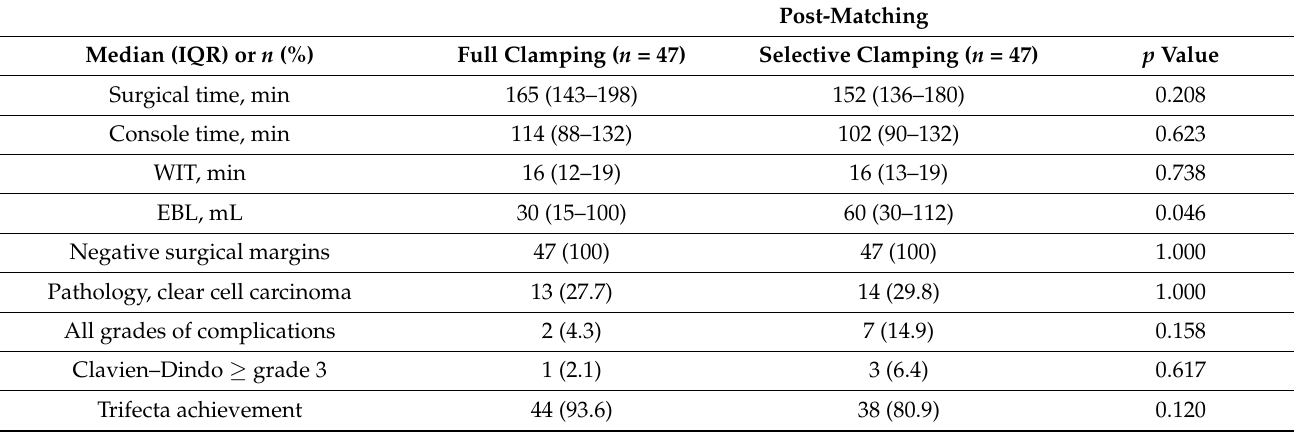
Table 2. Patients’ surgical